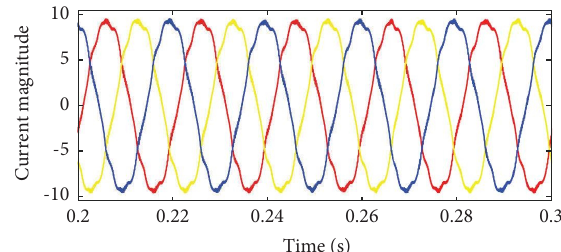
Figure 11: With the MPSO method, output current waveforms.